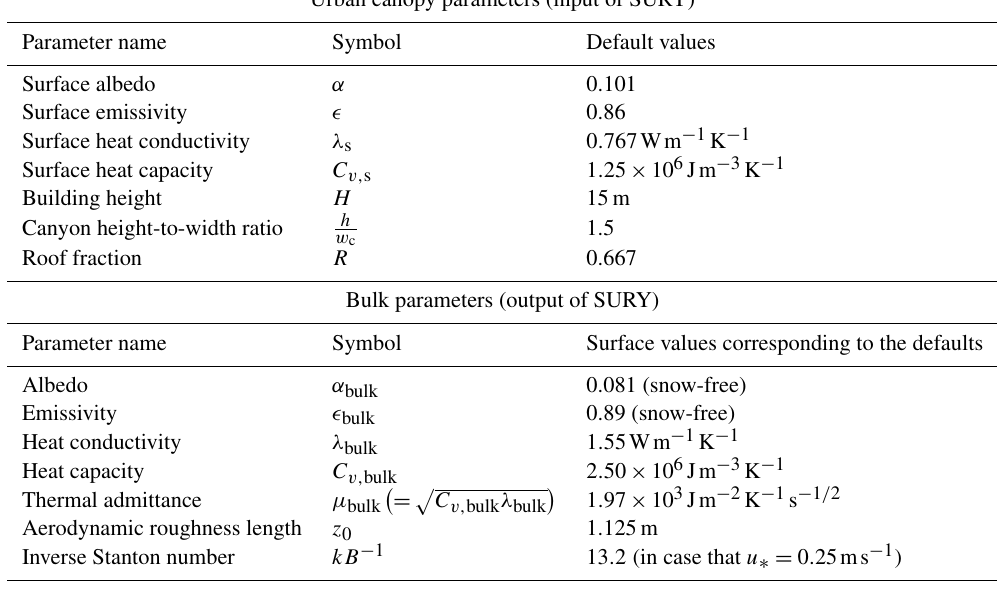
Table 1. The upper panel shows the urban canopy parameters. They are taken as input for the SURY. The default urban canopy parameters correspond to the recommended values for the medium urban category in Loridan and Grimmond (2012); see their Table 4 (stage 5b). The lower panel shows the bulk parameters, which is the output of SURY. The parameter u ∗ refers to the friction velocity. Urban canopy parameters (input of